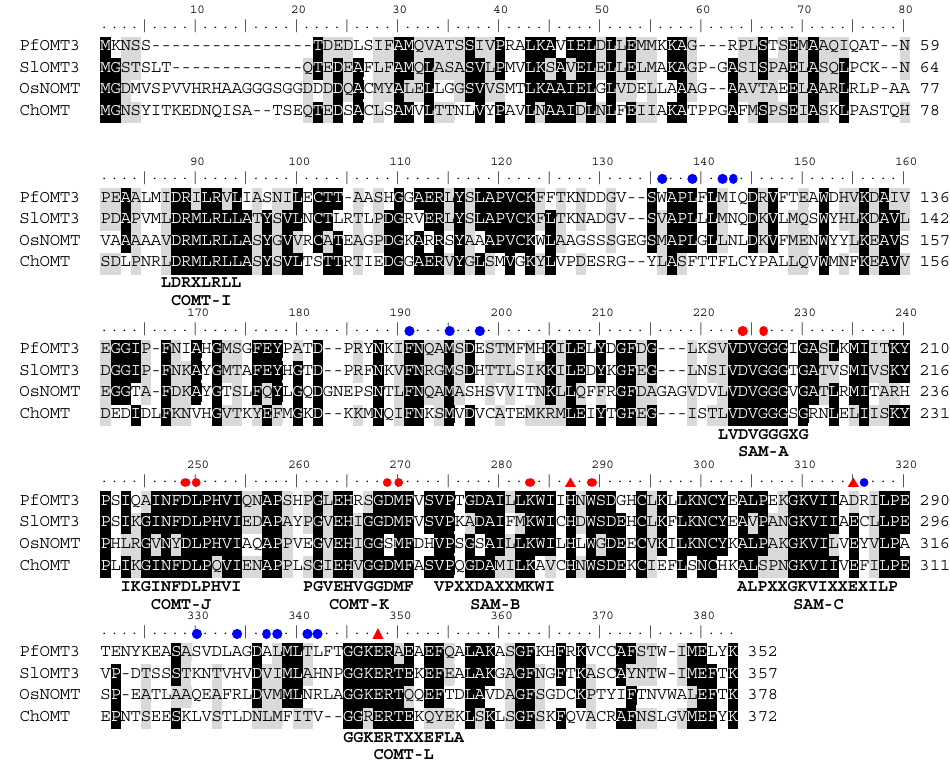
Figure 1. Multiple alignment of Perilla frutescens O -methyltransferase3 (PfOMT3) amino acid sequence with other class II O -methyltransferases (OMTs). Amino acid sequences of Solanum lycopercicum OMT3 (SlOMT3), Oryza sativa naringenin OMT (OsNOMT) and chalcone OMT (ChOMT) from alfalfa were used in the alignment. Three S -adenosyl-L-methionine (SAM)-binding motifs (SAM-A, B and C) and four caffeic acid OMT (COMT) motifs (COMT-I, J, K and L) conserved in class II OMTs are indicated with their consensus sequences under the aligned sequences. Red triangles indicate the three catalytic residues of class II OMTs. Red and blue circles indicate SAM-binding residues and substrate-binding residues, respectively. Identical and similar residues are shaded in black and gray, respectively.